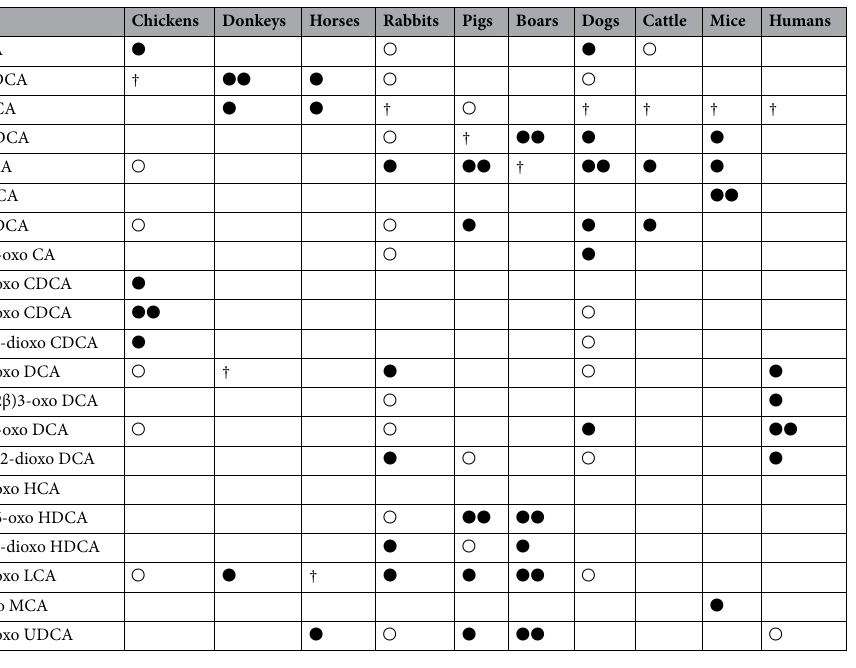
Table 2. Species-specific metabolic fingerprint from acidic sterolbiomes in animals and humans. ○ corresponds to a relative abundance < 1%, ● corresponds to a relative abundance < 10%, ●● corresponds to a relative abundance higher than 10%, † is used to highlight the most abundant